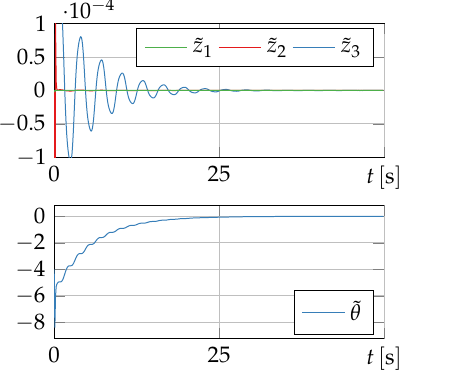
Figure 9. Results of the simulation with frequency